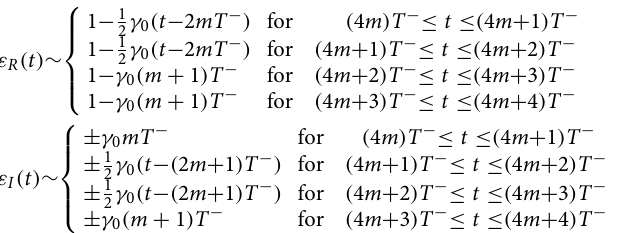
2 ε( t ) , solution of Eq. (6) in the main text and its real | | 501 , J 0.01 . In this regime intermittent blockade of 1 and α ρ = = = = 12 T − ∼